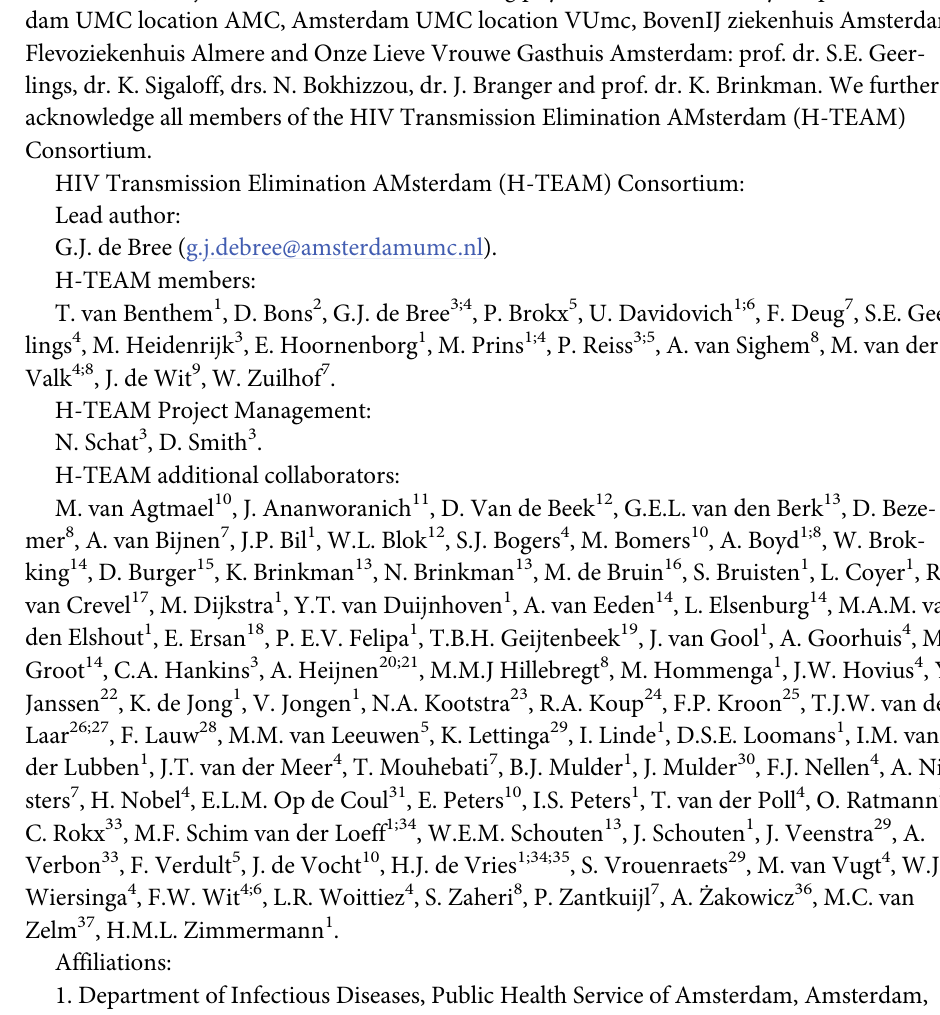
S2 Table. Interview guide for semi-structured interviews with hematologists working in the region of Amsterdam on factors influencing HIV testing behavior among malignant lymphoma patients. S3 Table. Interview guide for semi-structured interviews with authors of hematology guidelines working in the region of Amsterdam on the extent of and reasons for HIV test- ing recommendations in malignant lymphoma